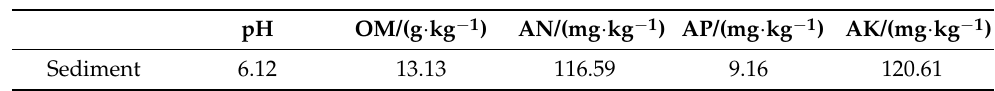
Table 1. Physical and chemical properties of